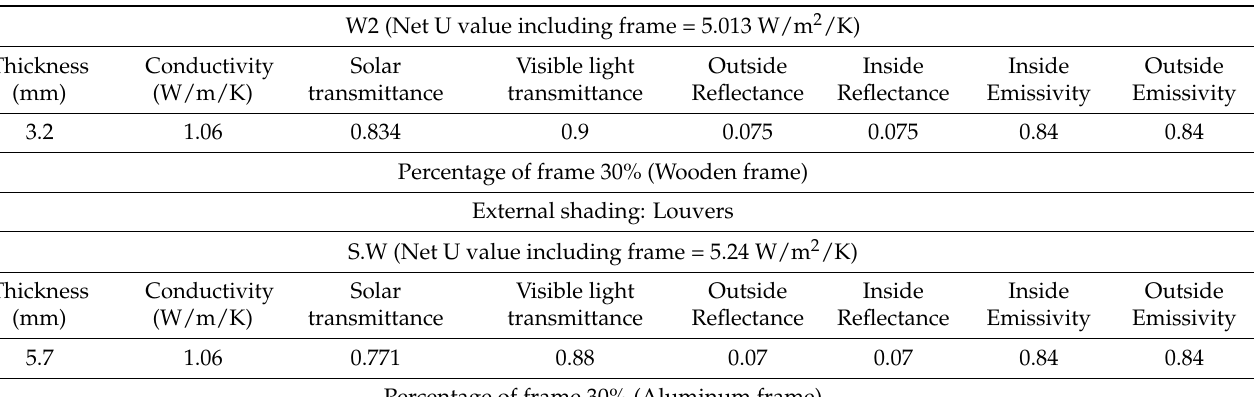
Table 2. Thermal properties of the transparent part of the